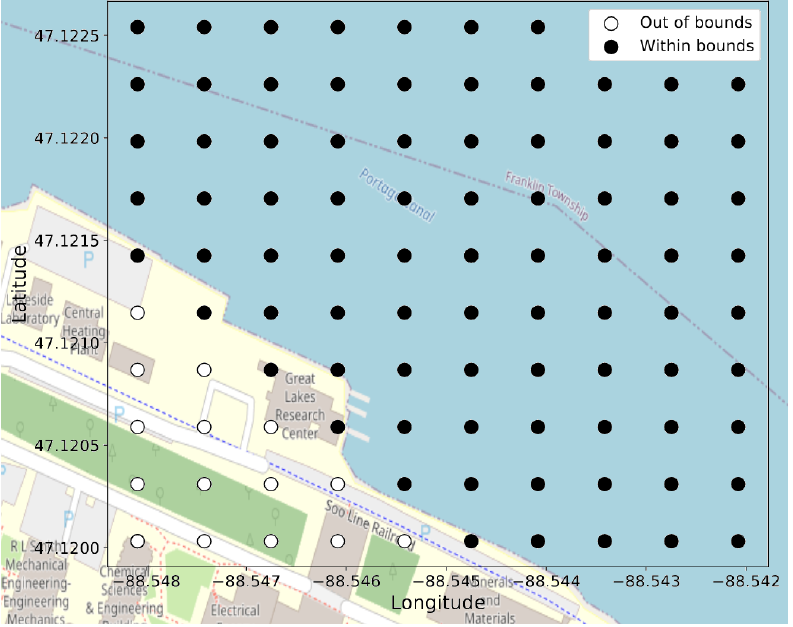
Figure 5. Eighty-five classes, out of the possible 100, for a 10 × 10 grid where the training and test data are not present in any of the “out of bounds”